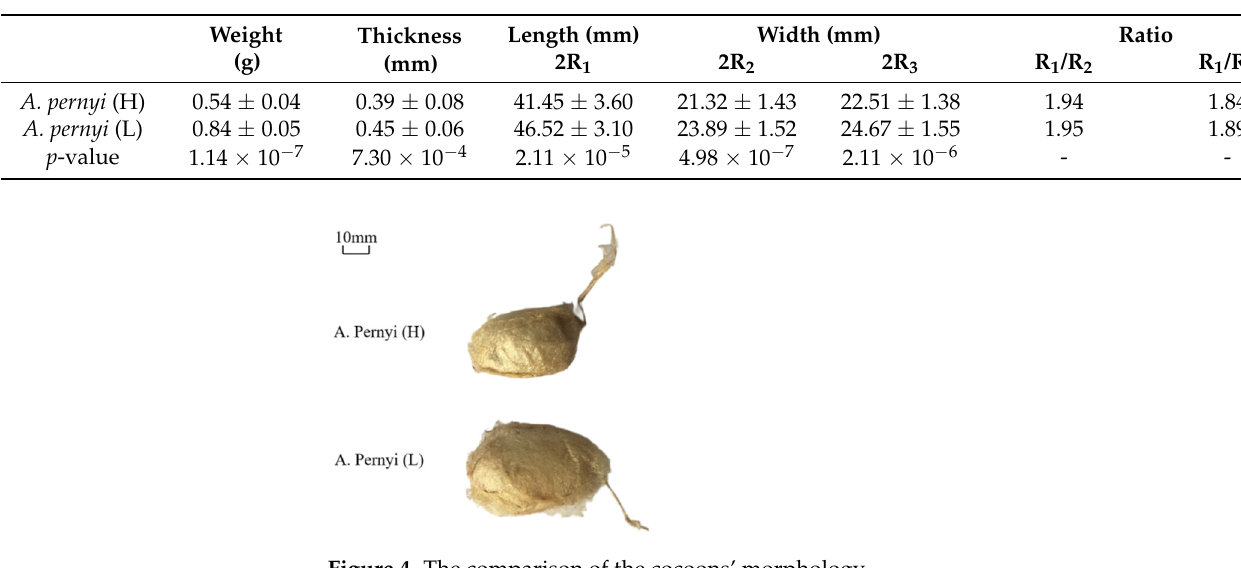
Table 1. Geometrical parameters of the A. pernyi cocoons from two different source regions (the error in this table is standard deviation).